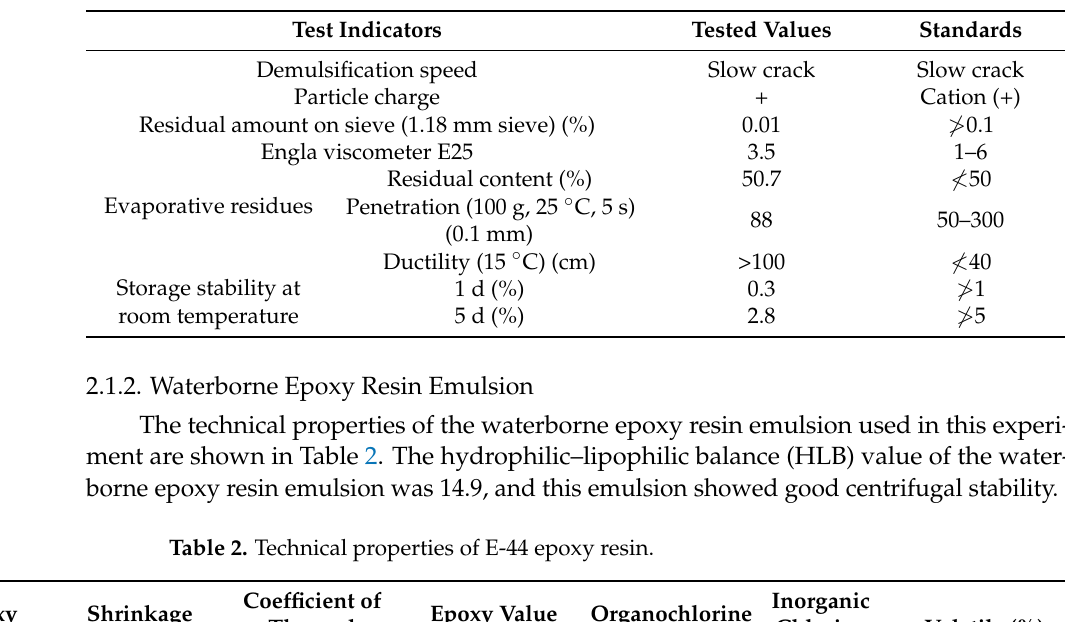
Table 1. Technical properties of BE-4-emulsified asphalt.